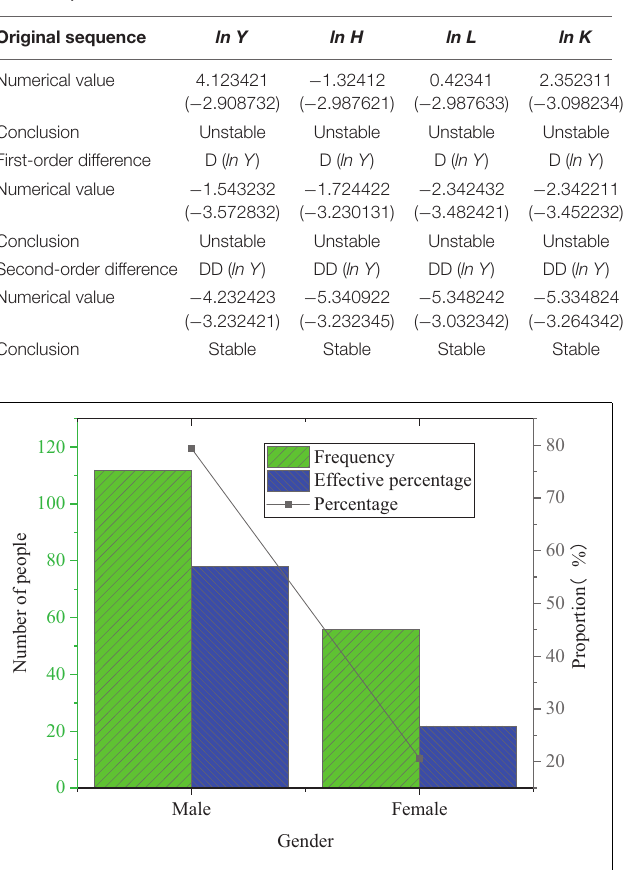
FIGURE 8 | Descriptive statistics of the gender of the sample entrepreneurs.